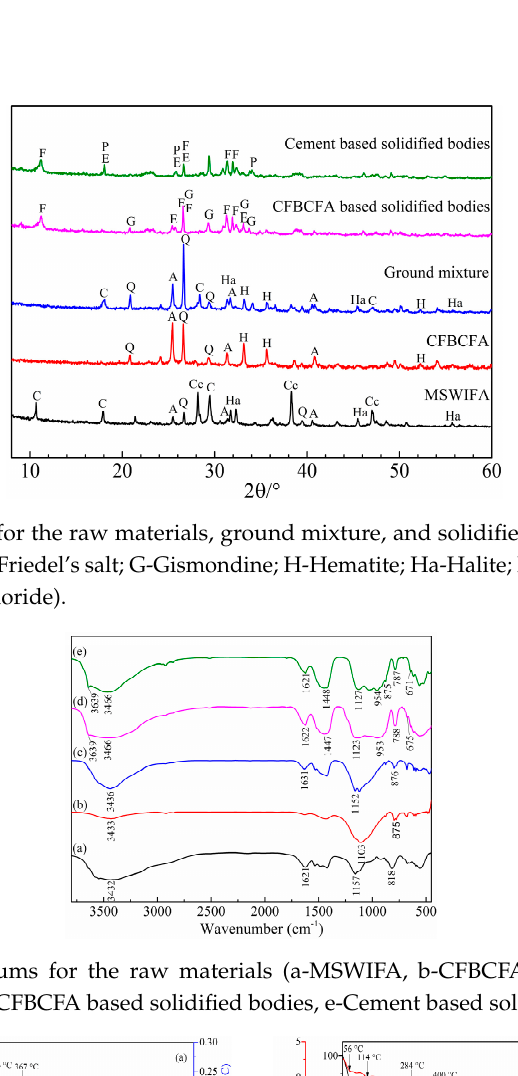
Table 3. The porosity and compressive strength of solidified bodies.